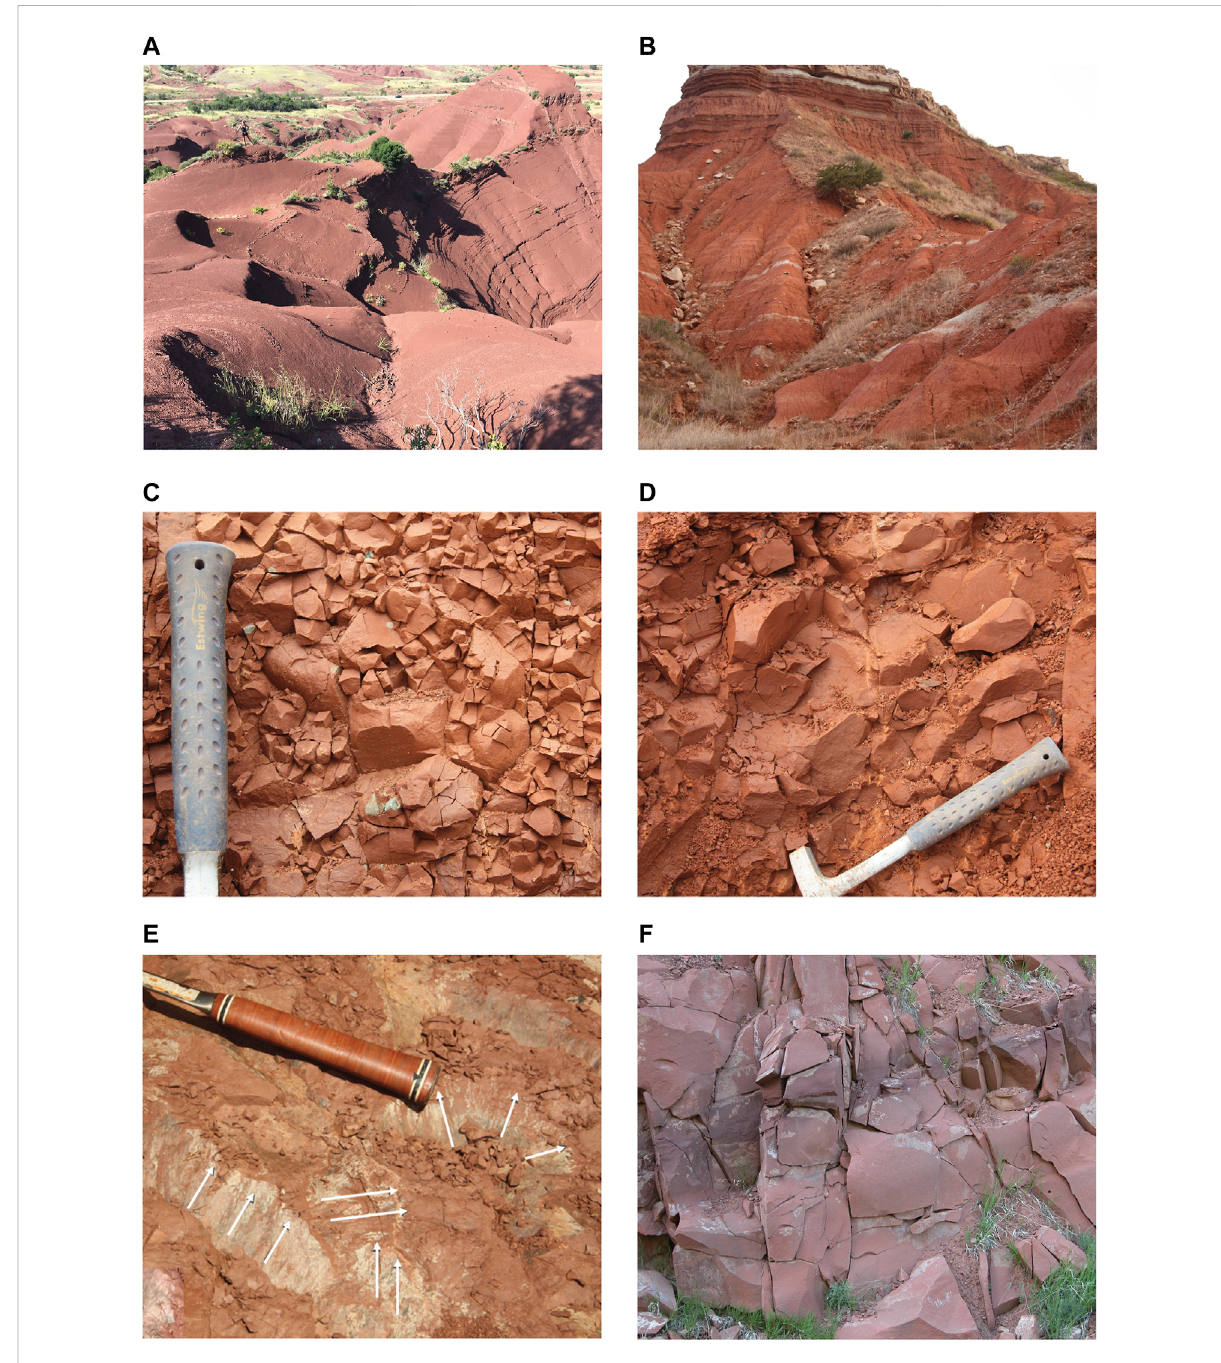
FIGURE 6 Macromorphological (outcrop-scale) attributes of loess and eolian-transported dust including (A,B) massive, structureless bedding from the Permian Salagou (France) and Flowerpot (OK, United States) formations, (C,D) blocky-to-angular fracturing from the Permian Dog Creek Formation (OK, United States), and (E,F) pedogenically-altered loessite from the Maroon (CO, United States) and Salagou (France)